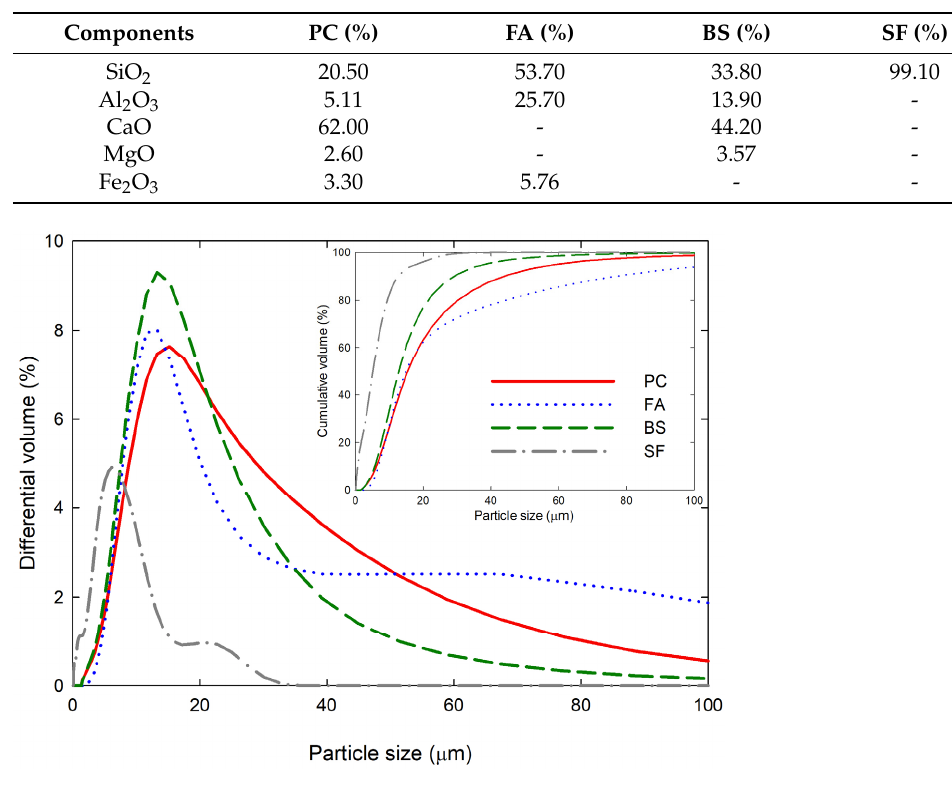
Figure 2. Particle-size distributions (PSDs) of cementitious materials.